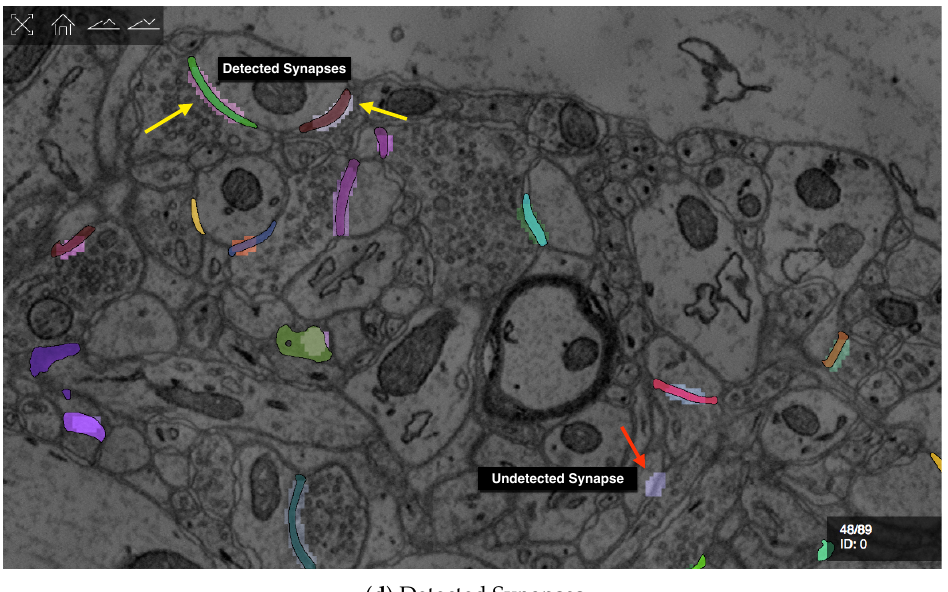
Figure 5. We developed RhoANAScope: a Web-based visualizer for neuron and synapse segmentations at scale. RhoANAScope visualizes segmentations on top of image data using WebGL. ( a ) Individual neurons are colored according to their cell membranes. ( b ) Pre- and post-synaptic markers are colored as green and blue, and indicate information pathways between neurons. ( c ) We use membrane probabilities to debug the automatic segmentations. ( d ) RhoANAScope is scalable to large data by implementing display-aware and demand-driven rendering, and supports multiple overlays. Here, we match a groundtruth segmentation of synapses with the output of our automatic synapse detection to view undetected synapses (red arrow) versus detected synapses (yellow arrows). Please note that the synapse detection visualized here is not